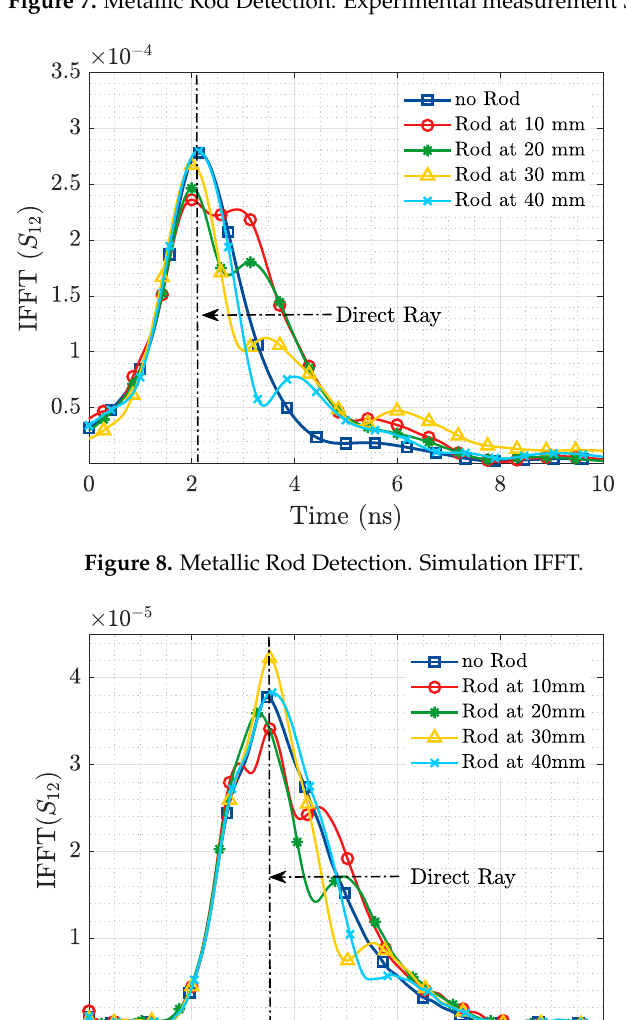
Figure 7. Metallic Rod Detection. Experimental measurement S 12 .